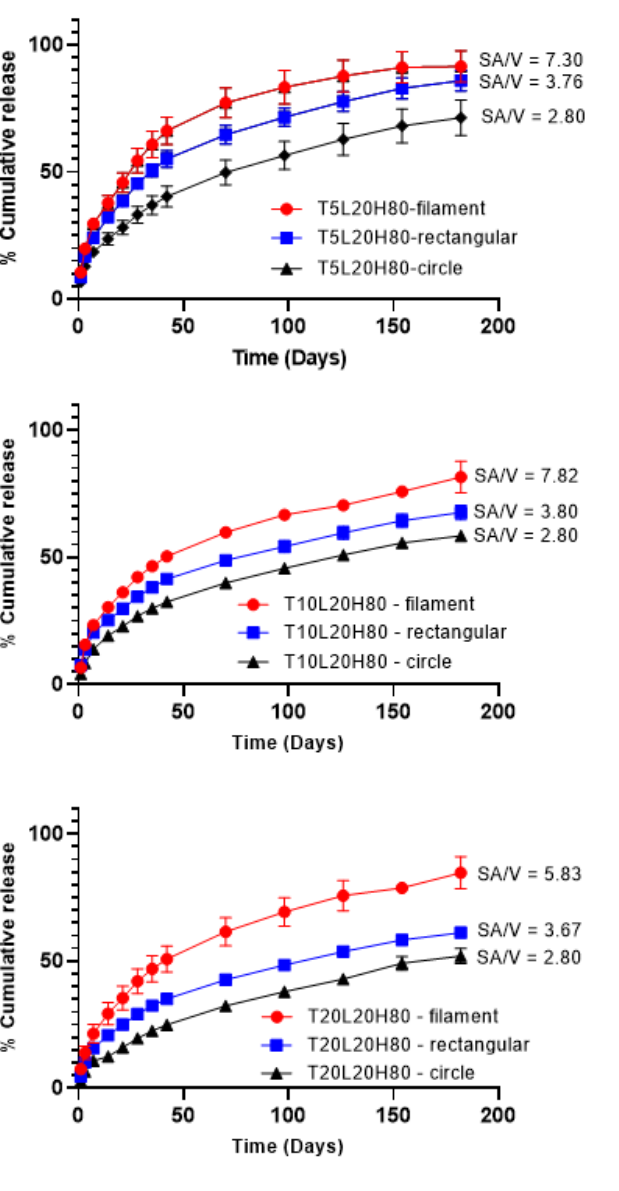
Figure 7. In vitro cumulative release of TA from PCL implants over 180 days. Results represent means ± SD (n = 3).